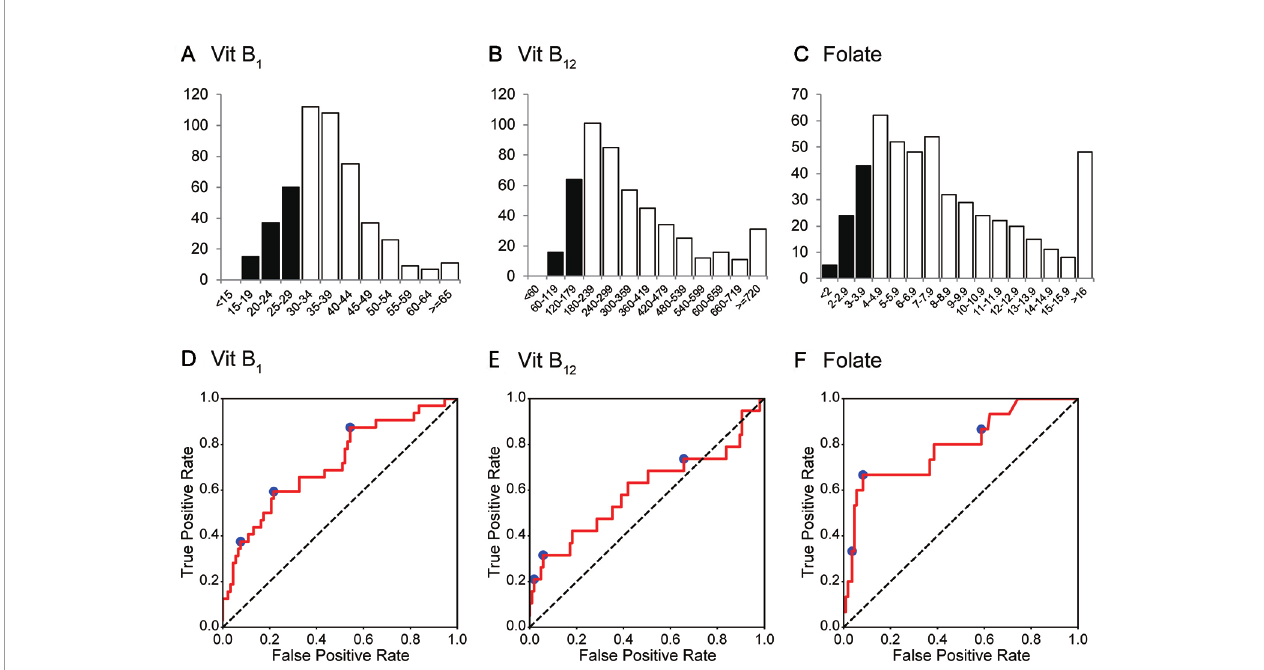
FIGURE 2 | Histogram and ROC curves of each vitamin B value. (A – C) The histograms for vitamin B 1 , vitamin B 12 , and folate (vitamin B 9 ). Their medians (1 st – 3 rd quartile) are 35 (30 – 42) ng/mL, 285 (206 – 431) ng/L, and 7.2 (4.9 – 10.8) m g/L, respectively. (D – F) ROC curves for vitamin B 1 , vitamin B 12 , and folate. Operating points used in Table 4 and Supplementary Table 5 are depicted in blue. Vit B 1 , vitamin B 1 ; Vit B 12 , vitamin B 12 .